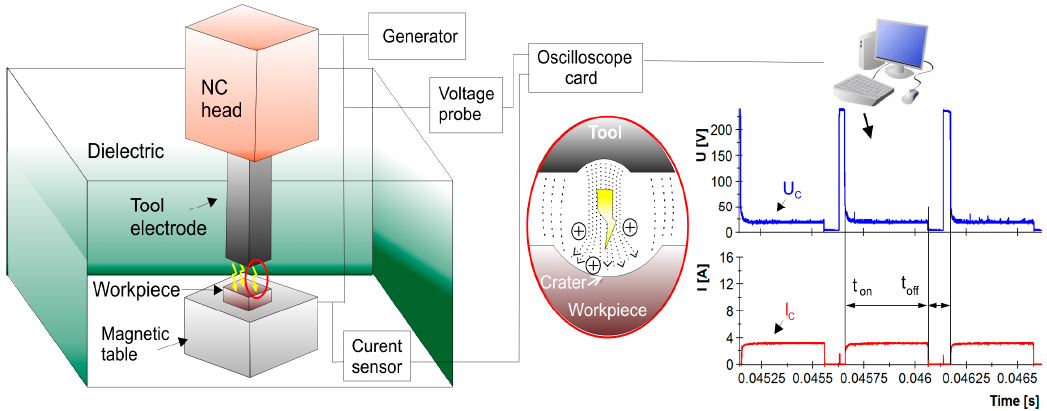
Figure 1. Scheme of the electrical discharge machining (EDM) process measuring the current voltage characteristics.